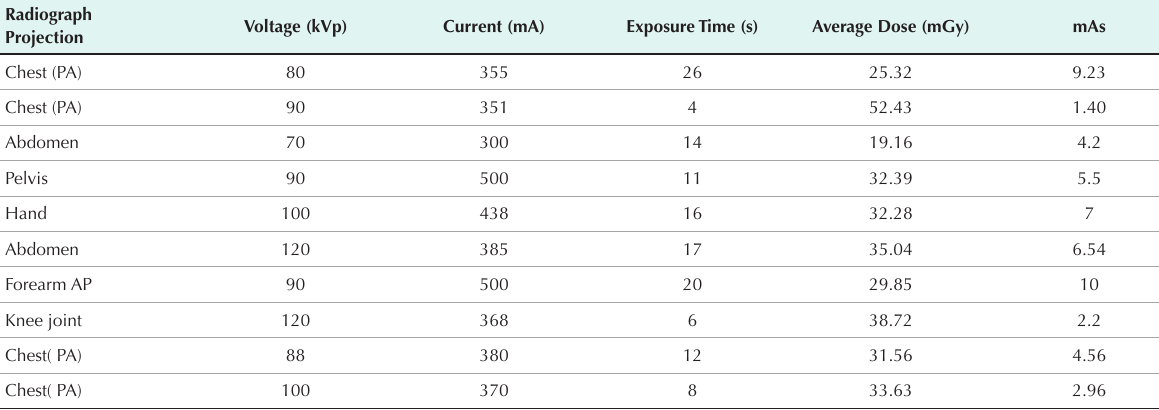
Table 2. The Technical Parameters of X-ray Tube for Age Group of 42-70 Years Radiograph Projection